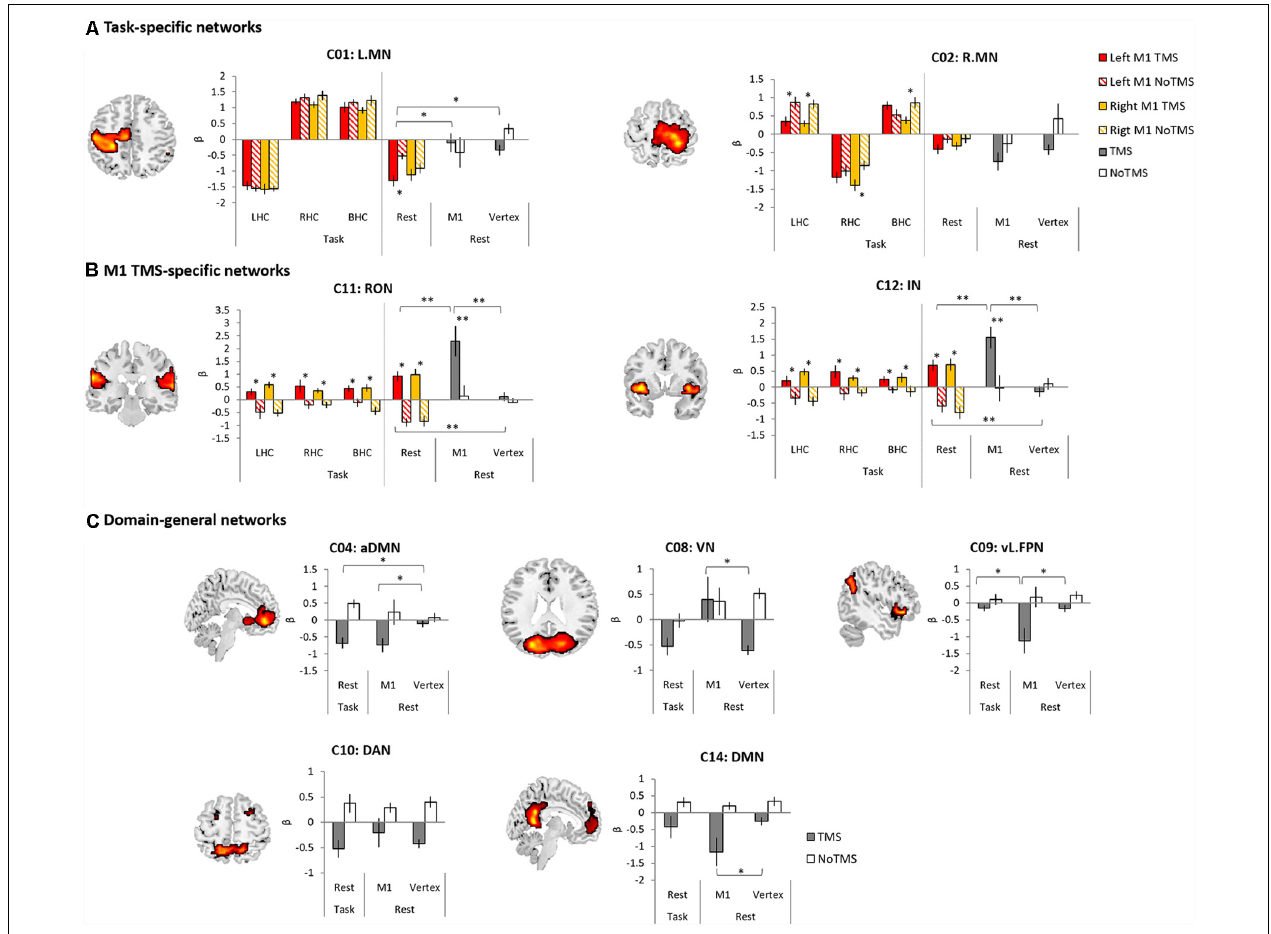
FIGURE 5 | The results of temporal regression analysis between groups. (A) Task-specific networks. (B) M1 TMS specific networks. (C) Domain-general networks. The bar filled color indicates the TMS phase and the bar filled with diagonal lines indicates the No TMS phase. Red (left M1 TMS) and Yellow (right M1 TMS). Gray bar indicated TMS phase and white bar indicate NoTMS phase. Error bars indicate standard errors. ∗ p < 0.05, ∗∗ p <